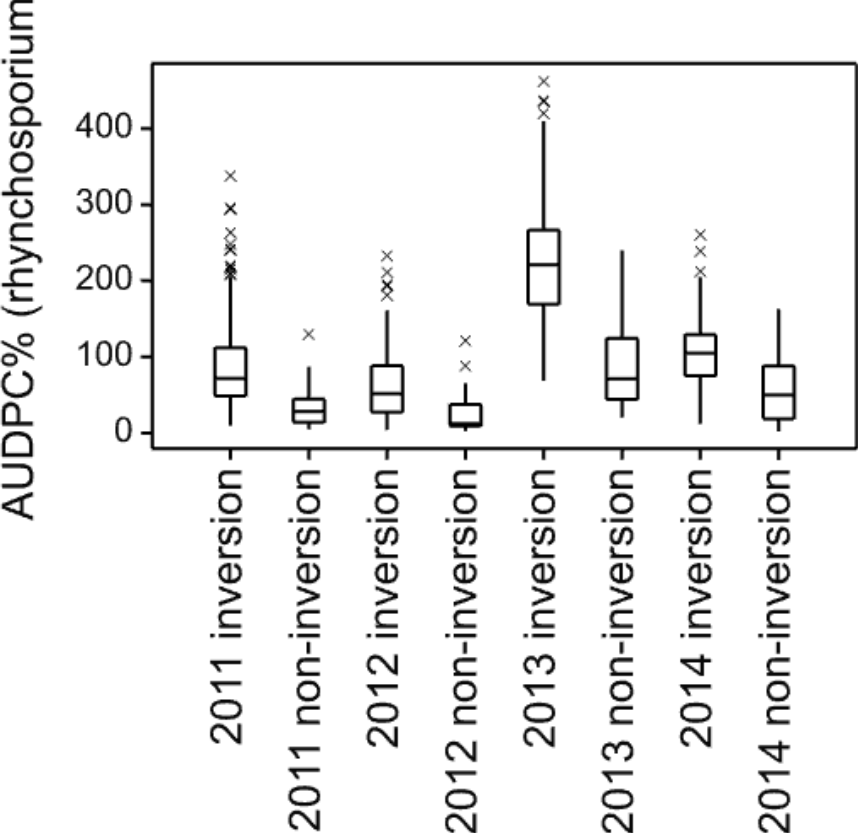
Figure 7. Mean area under the rhynchosporium disease progress curve (square root transformed) of 18 cultivars in inversion and non-inversion tillage from 2011 to 2014. Table 6. Ranking of 18 winter barley cultivars grown from 2011 to 2014 by the difference between their inversion and non-inversion area under their rhynchosporium disease progress curve (%AUDPC) (sqrt) ranking. %AUDPC Cultivar %AUDPC Inv. Rank Inv. Rank Non-Inv. Rank Diff. Non-Inv.